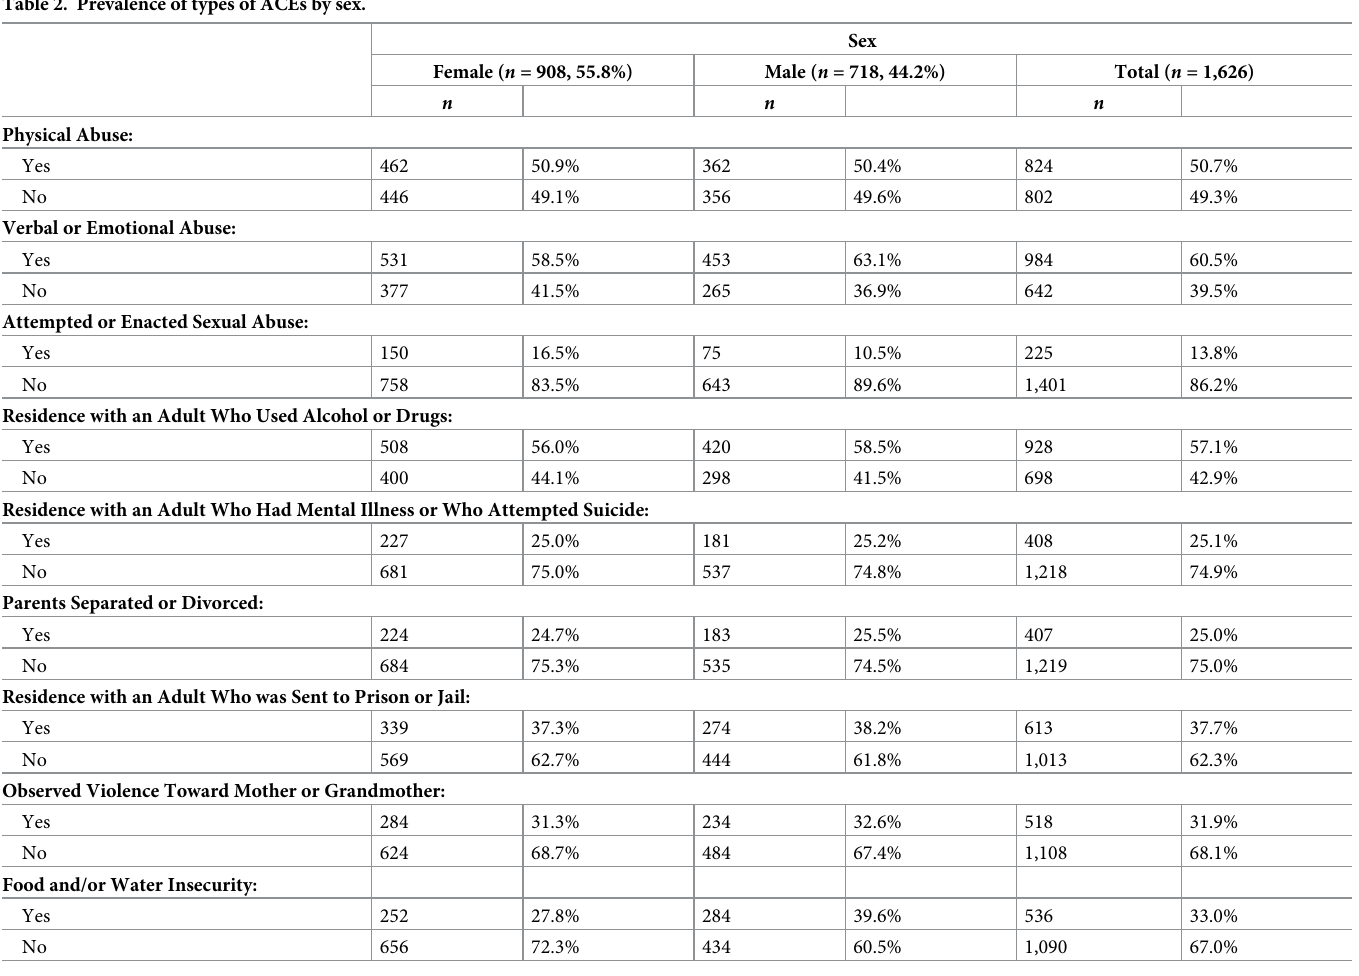
Table 2. Prevalence of types of ACEs by